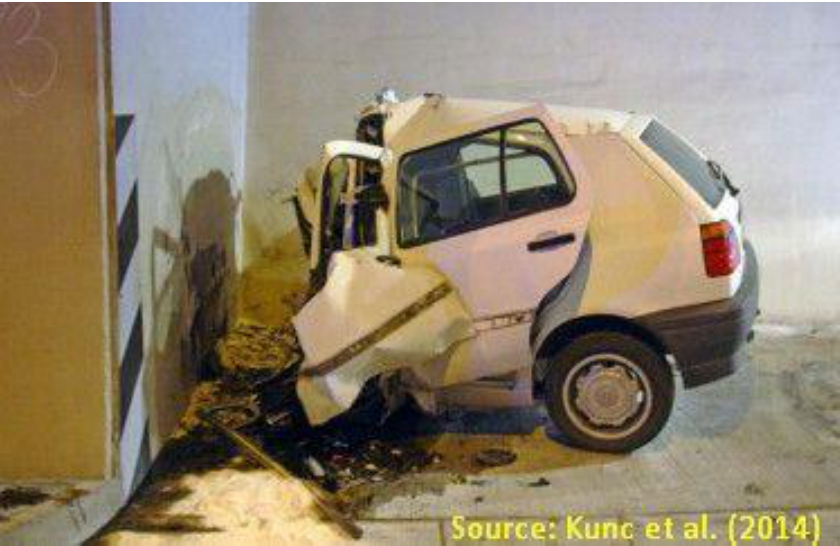
Figure 1. Tunnel accident at the end-wall of an unprotected tunnel lay-by (Source: Fire Brigade Koper in Kunc et al. [2]).